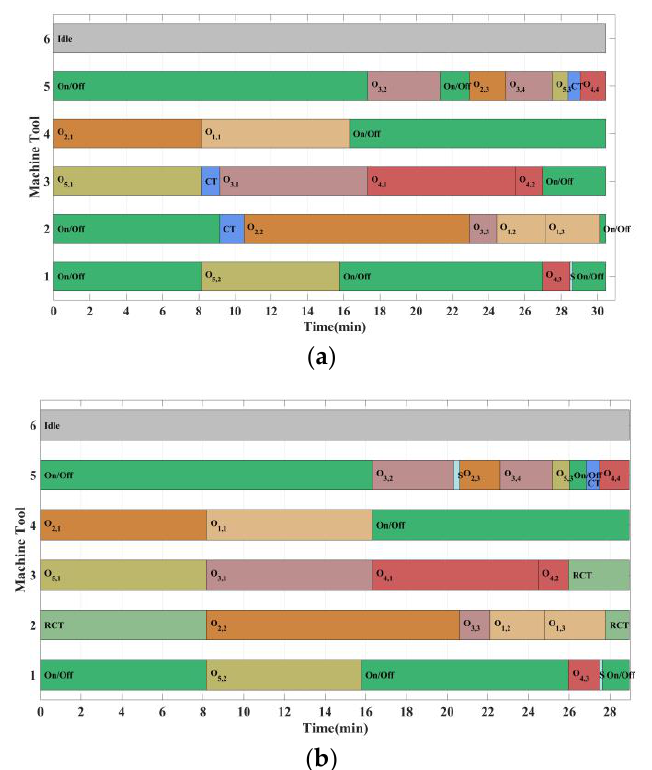
Figure 28. Comparison of scheduling schemes before and after the hybrid energy-saving strategy: ( a ) Before the hybrid energy-saving strategy; ( b ) After the hybrid energy-saving strategy.